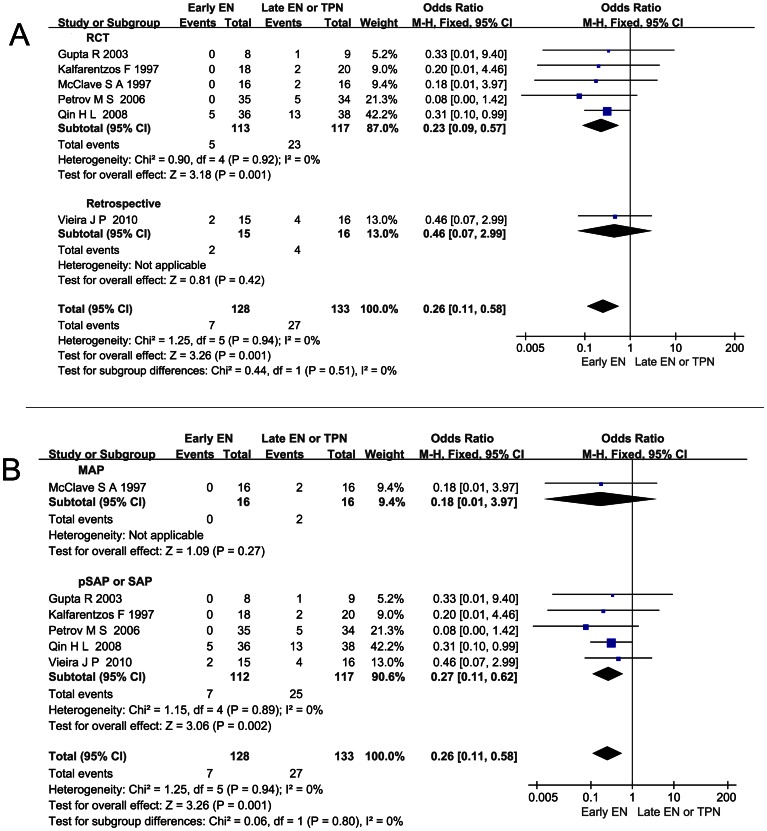
Effect of early EN on catheter-related septic complications of AP.(A) Forest plot (Fixed-effect model) showing the effect of early EN on catheter-related septic complications of AP and the sensitivity analysis subtotaling the plots by RCTs vs. retrospective studies. (B) Forest plot (Fixed-effect model) of the stratified study conducted based on the severity of AP.